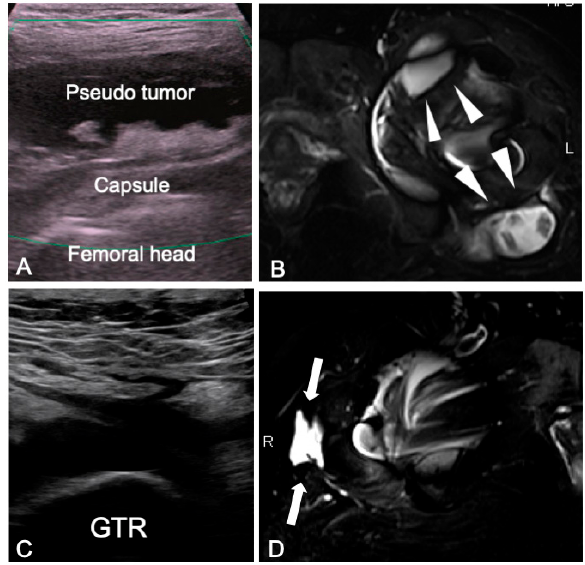
Figure 5. Representative abnormal images taken using ultrasonography and MRI in the hip resurfacing patients. ( A , B ): A pseudotumor was detectable in the anterior long axis of the hip by ultrasonography as a free echoic space above the femoral head ( A ). MRI provided information regarding the area of spread and lesion properties (white arrow heads) that is vital for the preoperative assessment of the pseudotumor ( B ). The trochanteric synovium was detected by ultrasonography in a patient with lateral thigh pain as a free echoic space located above the greater trochanter ( C ). MRI also provided information on local fluid collection (white arrows) at the lateral side of the greater trochanter ( D ). Among the 41 non-pseudotumor hips in our present HRA series, 4 cases were diagnosed with greater trochanteric bursitis through the detection of fluid accumulation on an MRI scan with sharp local pain recorded on the greater trochanter. In these four patients, a low echoic region around the greater trochanteric was observed on ultrasonography (Figure 6). In one case, iliopsoas impingement was diagnosed through clinical symptoms that included hip flexion pain which immediately improved after an ultrasonography-guided Xylocaine injection. No structural abnormality was observed on the iliopsoas by either MRI or ultrasonography in this case. Overall, both MRI and ultrasonography detected a periprosthetic abnormality in eight out of nine hips that manifested unusual pain after the HRA